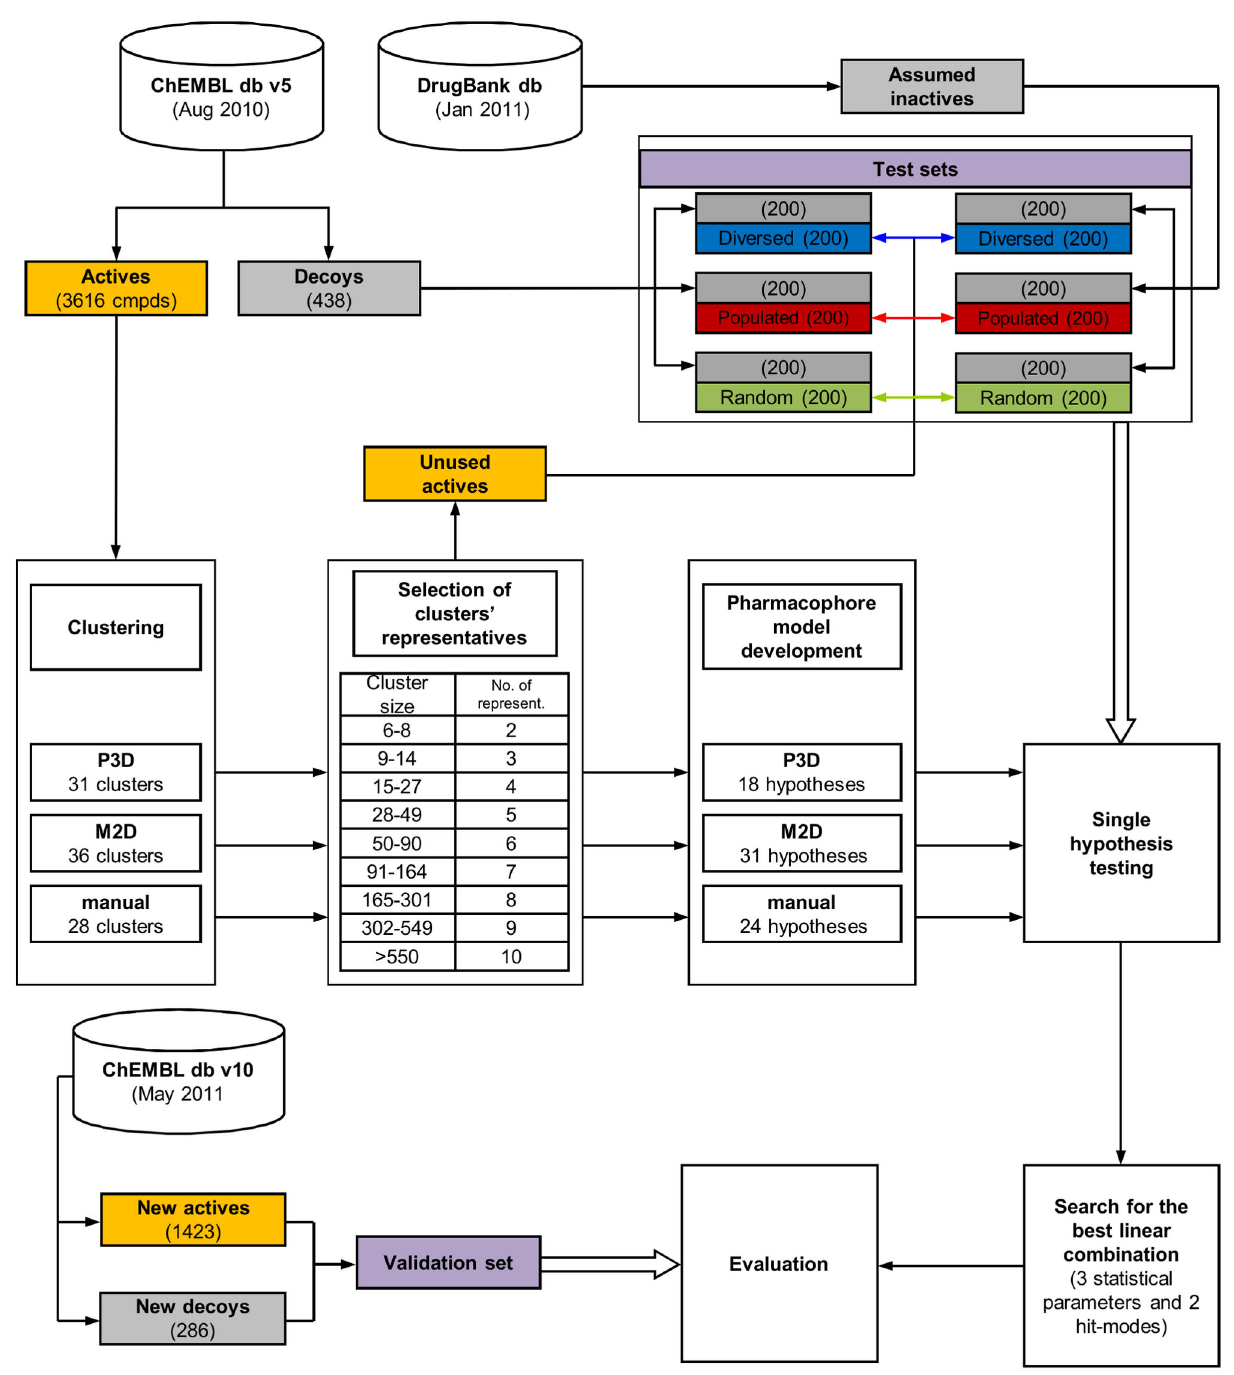
Figure 1. The development of an optimal combination of pharmacophore models. The development of an optimal combination of pharmacophore models. Transparent boxes show the logical steps of the workflow; cylinders represent data sources; colored boxes reflect the compound character: gray – inactives, orange – actives or the active’s selection method (blue, red or green), which is consequently used in subsequent figures. The population of the compound set is given in brackets. Thick arrows indicate the use of data